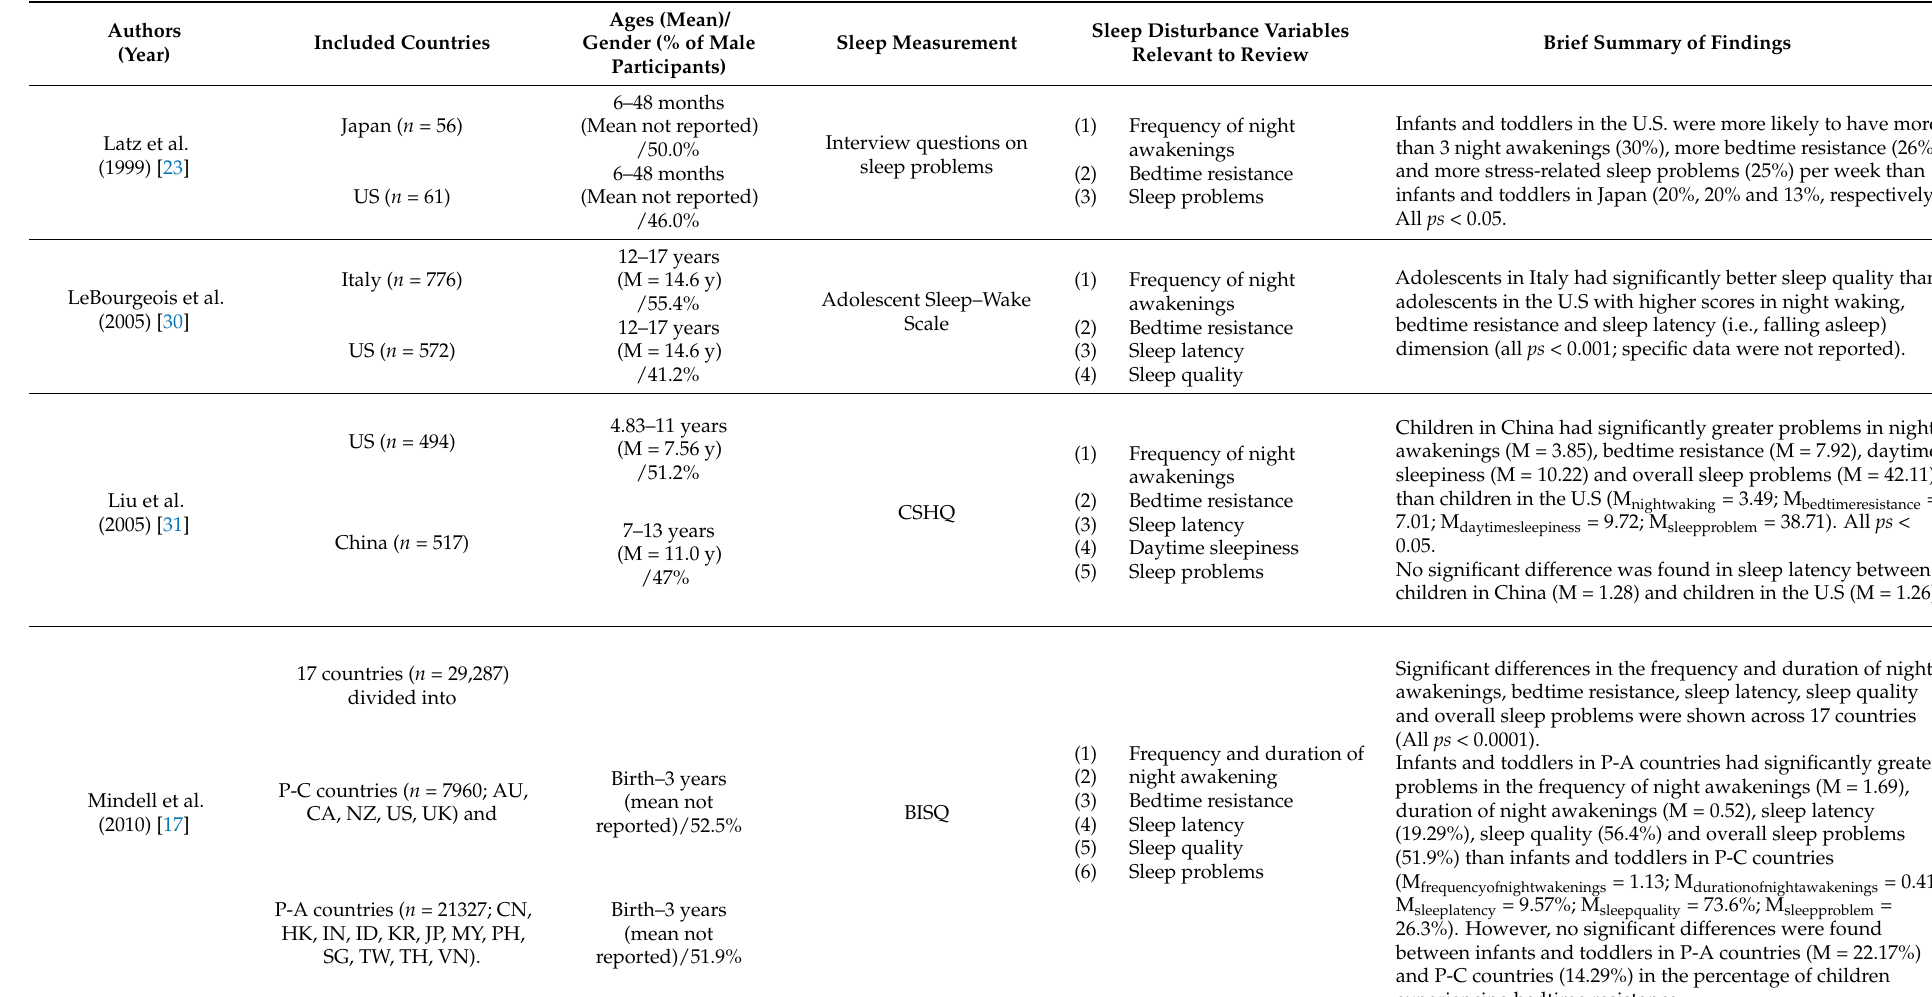
Table 2. Characteristics of included studies relating to sleep disturbance